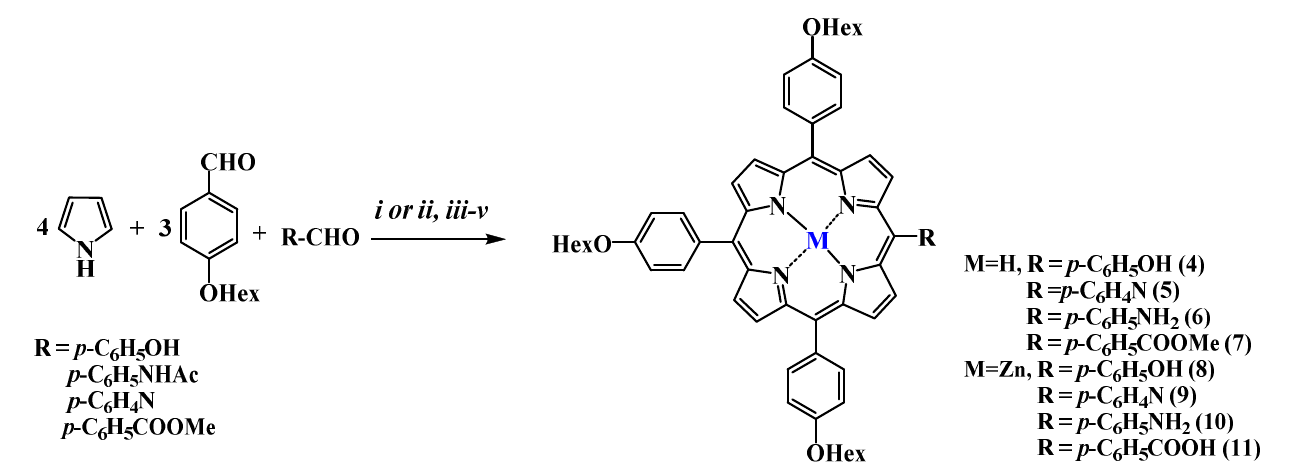
Scheme 3. Synthesis of porphyrins and their complexes with Zn.